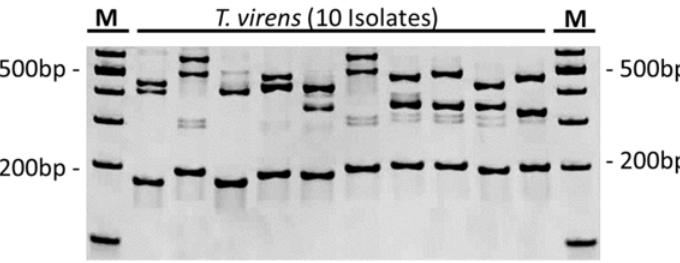
Figure 2. Multiplex PCR with primers TvCAG 13 , TvCTTTT 27 and TvGAAA 34 examined on a 5% PAA gel. The order of isolates corresponds to Figure 1. M = 100 bp DNA length